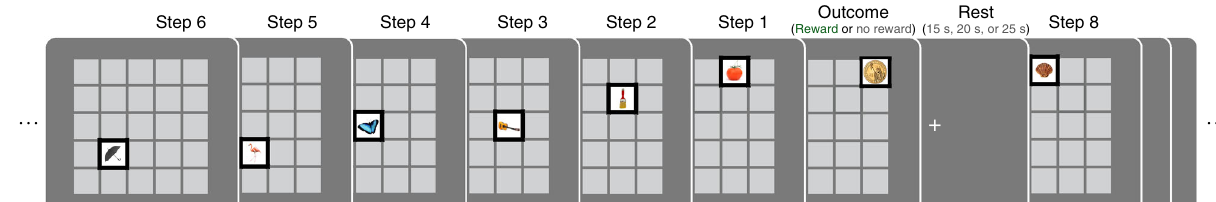
Supplementary Figure 1b and Supplementary Figure 3a, Supple- mentary Note 1, for post hoc tests see Supplementary Table 2).